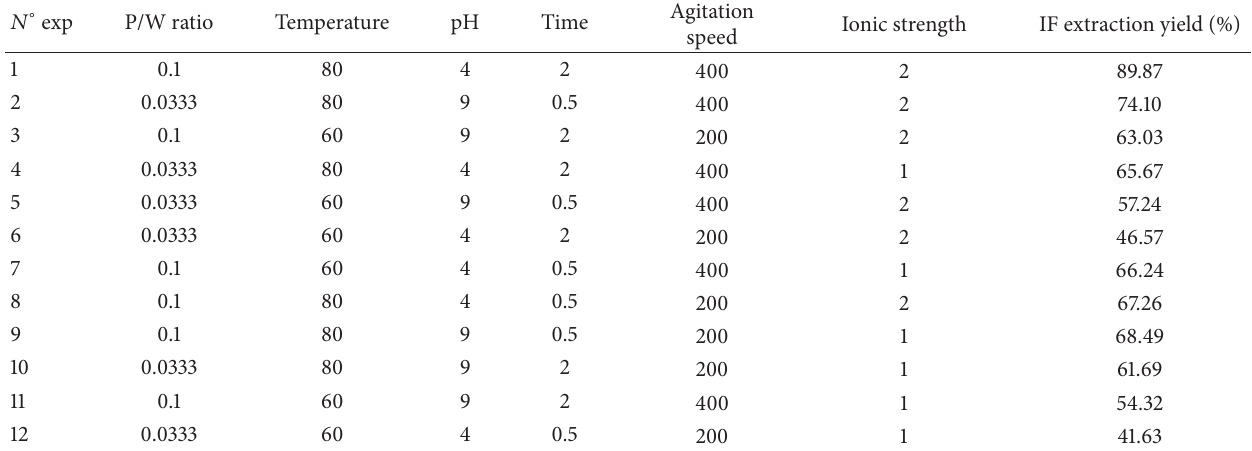
Table 4: Experimental conditions of Plackett-Burman design for insoluble fibres extraction and the corresponding experimental responses. 𝑁 ∘ exp